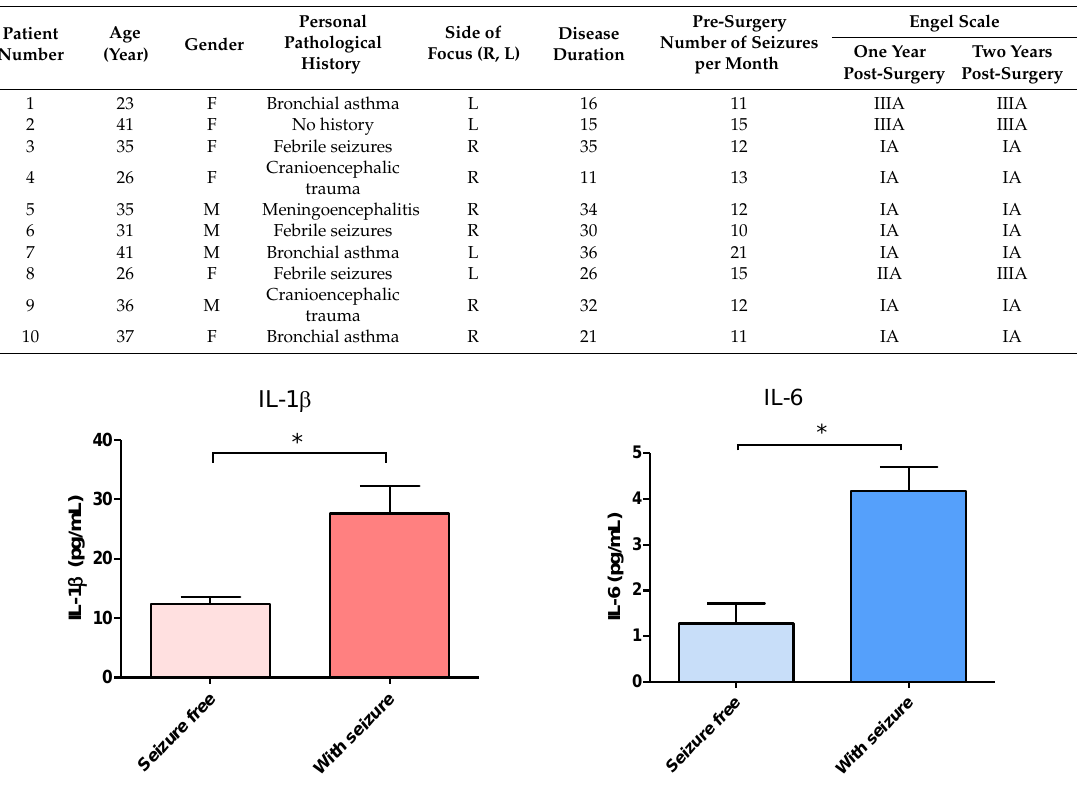
Figure 2. Concentration in serum of Interleukins according to the presence or absence of seizures one year after surgery. ( A ) IL-1 β . ( B ) IL-6. The bars represent the mean ± the standard error of the mean. Mann Whitney test, * p ≤ 0.048.